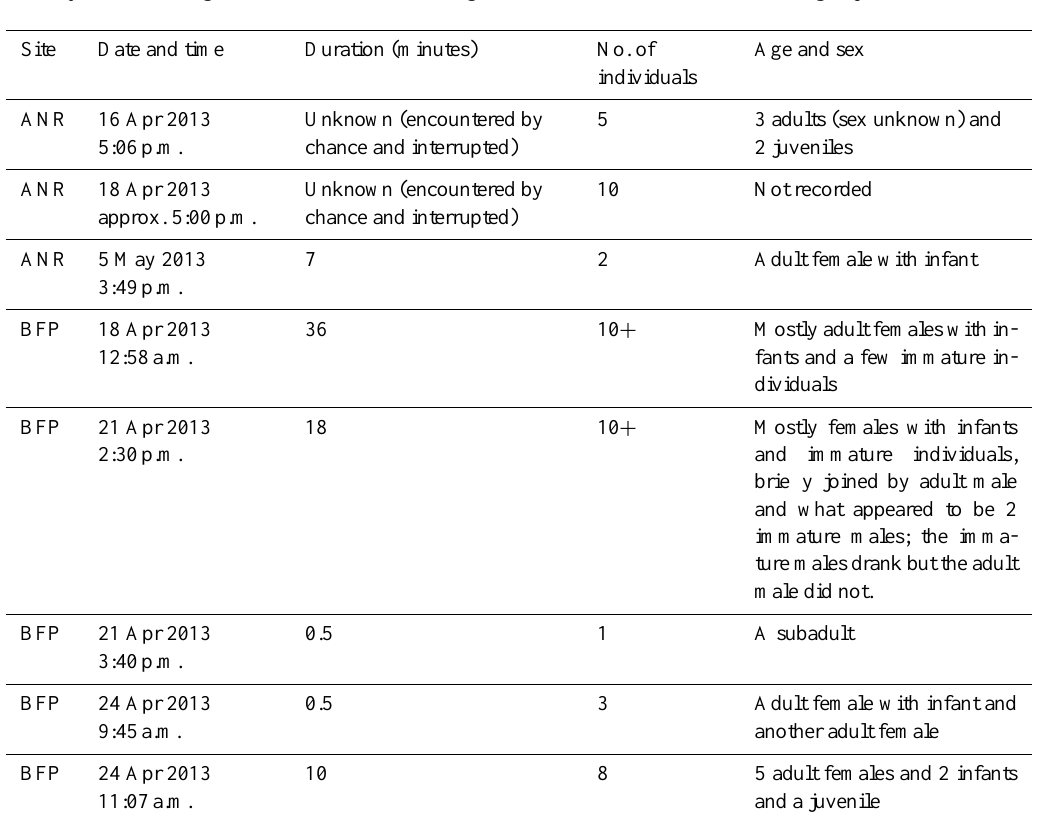
Table 1. A summary of all drinking events observed (ANR being Abuko Nature Reserve and BFP being Bijilo Forest